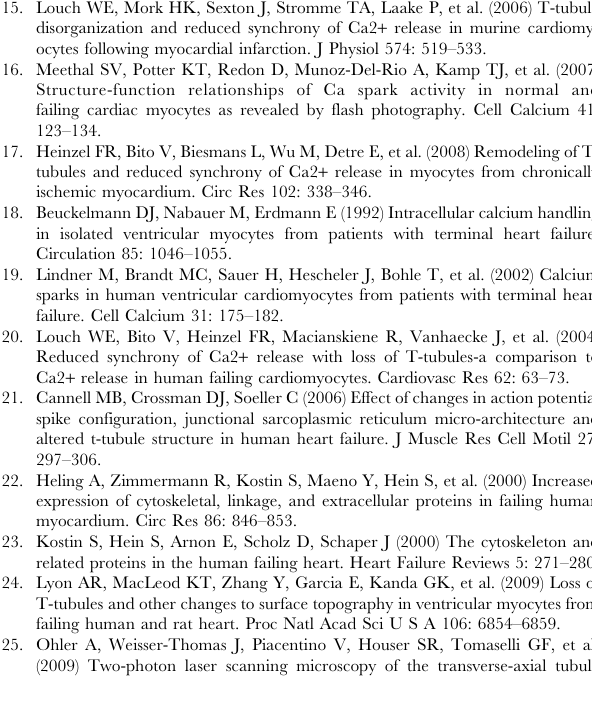
Figure S1 DHPR immunohistochemistry with an alter- native antibody gives generally similar DHPR